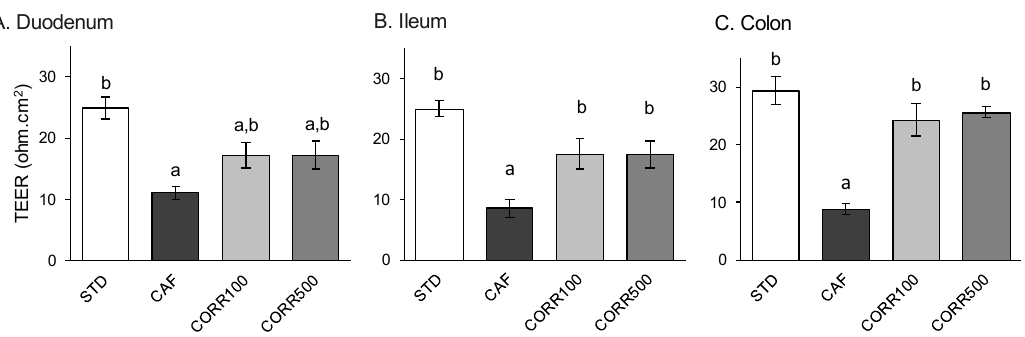
Figure 3. The effect of the GSPE treatment on the intestinal barrier integrity of small and large intestines in diet-induced obese rats. TEER (transepithelial electric resistance) values were estimated from fresh duodenal, ileal and colonic mucosal preparations mounted in an Ussing chamber system. Values represent mean ± SEM; n = 8–10. Different letters indicate statistically significant differences between groups ( p < 0.05); ANOVA test followed by Tukey’s HSD test when variances were equal and Dunnett’s T3 test when they were not.